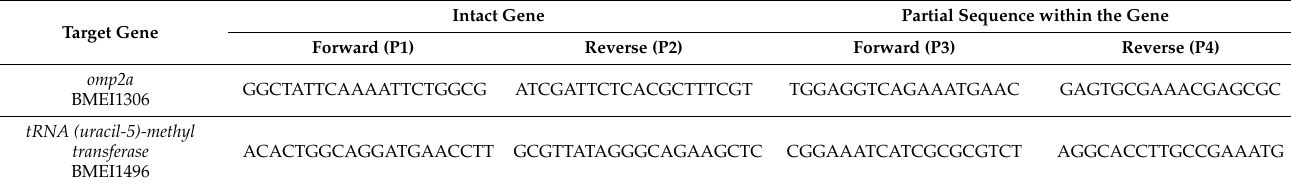
Table 1. Primers used in the